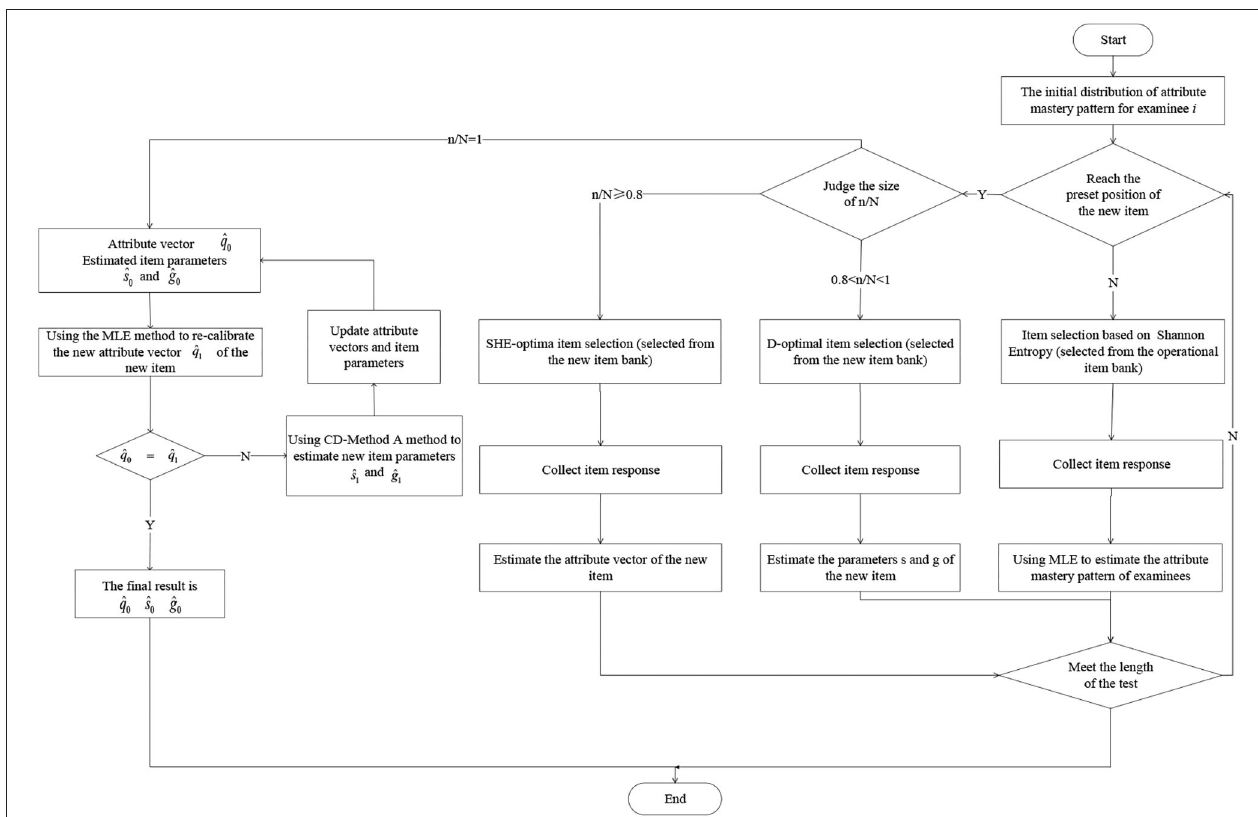
FIGURE 3 | Flow chart of adaptive design for online estimation and calibration.